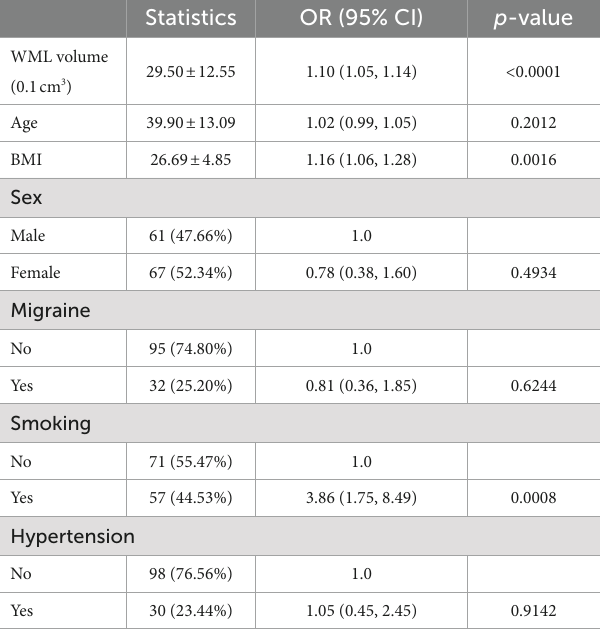
TABLE 3 Results of univariate analysis between white matter lesions volume (<6,200 mm 3 ) and bipolar disorder